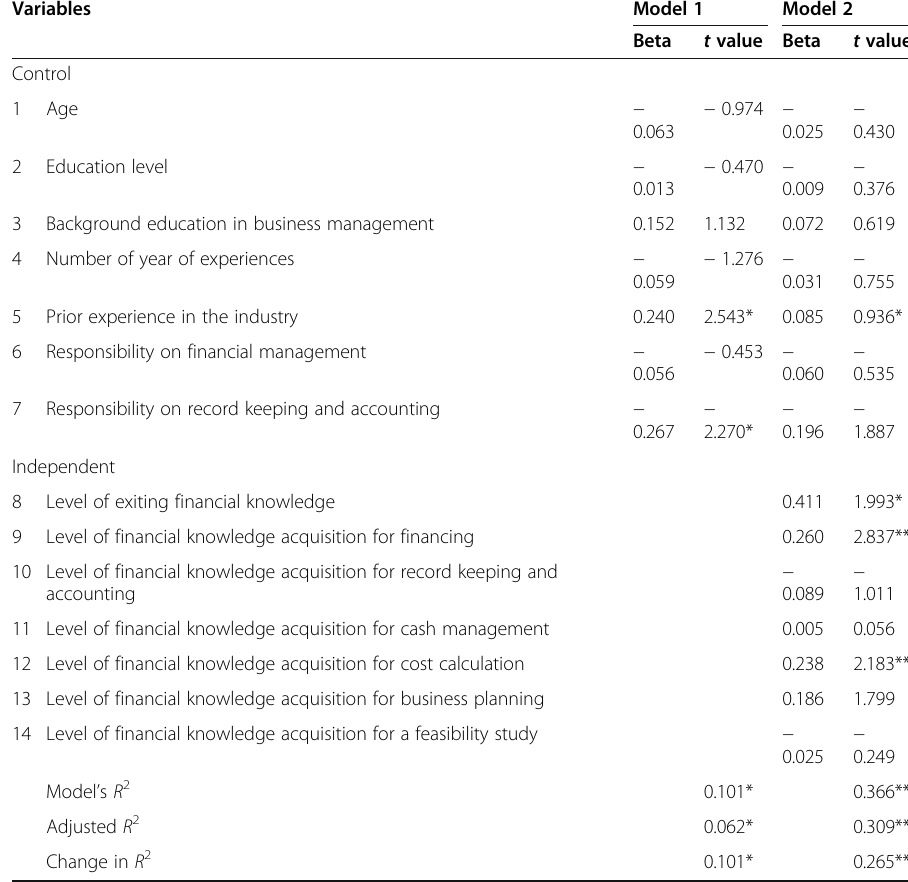
Table 5 Regression: Level of need for KA